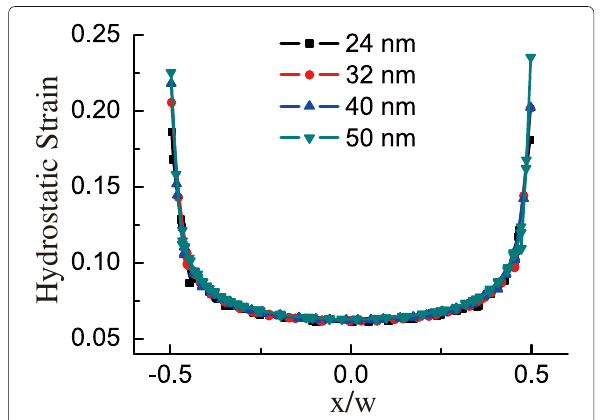
Fig. 5 Hydrostatic strain component at the base of GeNW vs. x/w with different basal widths